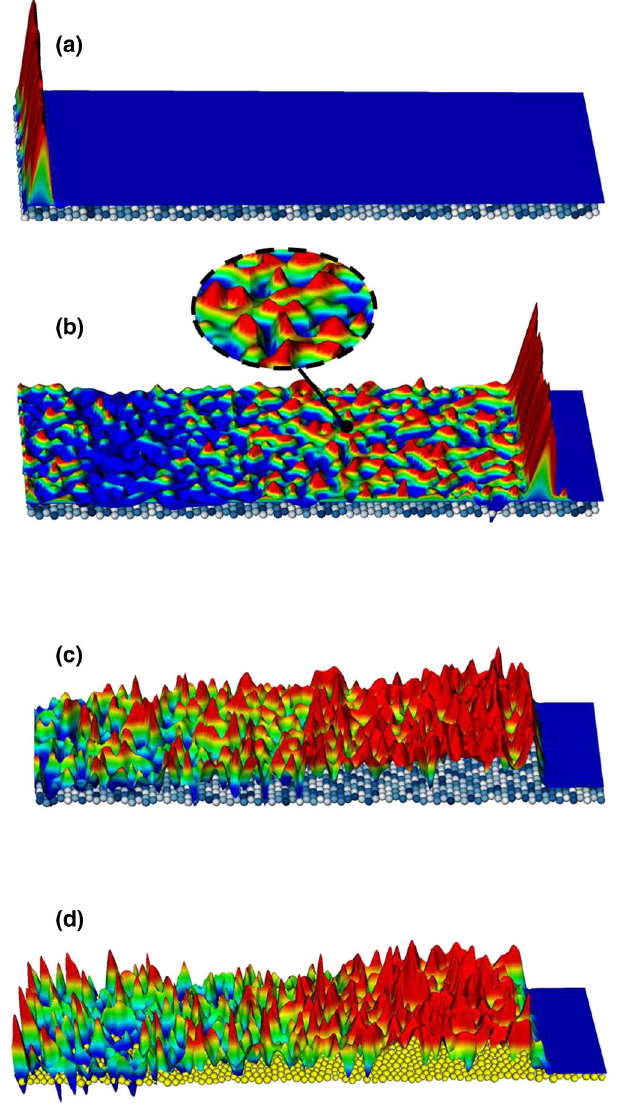
FIG. 2. (a) Solitary-wave formation after an impulse perturba- tion applied to a hexagonal lattice of grains in a sonic vacuum. (b) The interaction of the solitary wave with the mass disorder leads to the decay in the wave amplitude. The process of energy loss is such that it excites several smaller solitary waves. (c) For strong mass disorder and (d) in amorphous packings, the initial solitary wave is now no longer identifiable. Instead, we observe a triangular shocklike profile that is defined as an envelope over the smaller excitations. (b),(c),(d) Waves at similar distances of the original impulse perturbation are represented. (Wave amplitudes are rescaled for better visualization.)